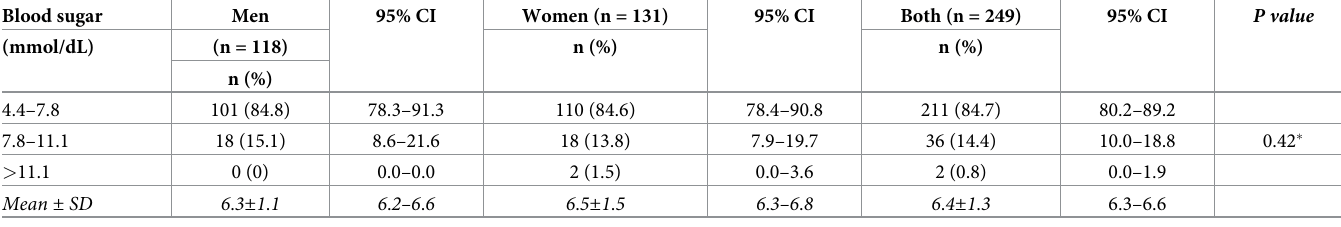
Table 4. Biochemical risk factors the respondents (n =